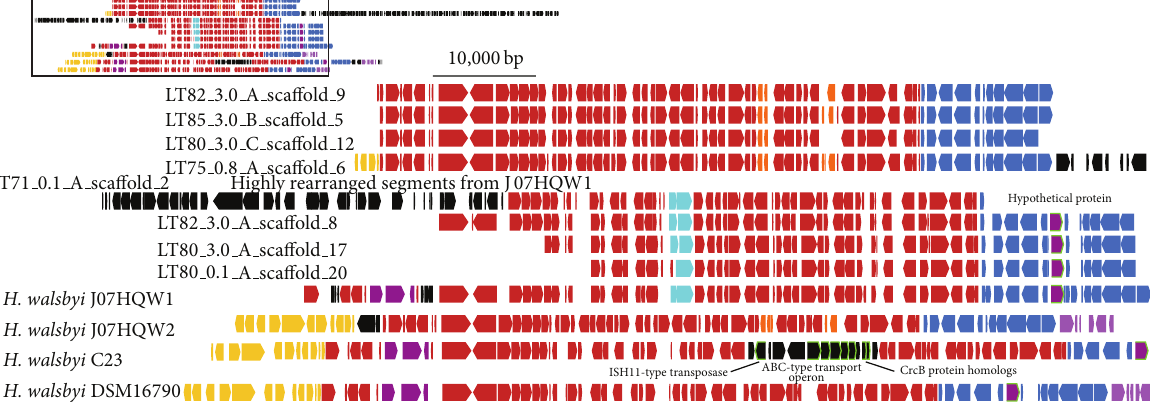
Figure 3: Inset: a gene map of the region spanning 2,619,000–2,702,000 bp along the H. walsbyi J07HQW1 genome, the corresponding regions in the other H. walsbyi genomes , and the environmental contigs. Full image: an expanded view of the region denoted in the inset. Syntenic regions are marked by matching colors. Arrows highlighted in green denote individual sequences specifically identified in the paper. Environmental contigs use a long form identification number (see Figure 1 caption). The regions represented on the gene map from each genome are as follows: J07HQW1, 2,619,269–2,703,165 bp; J07HQW2, 1,229,374–1,314,534 bp; C23, 2,110,000–2,220,000 bp; DSM16790, 2,030,000–2,125,000